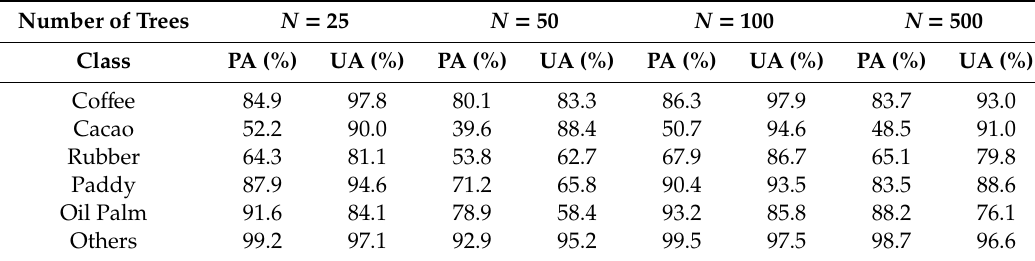
Table 3. Producer’s (%) and User’s (%) accuracy of classified maps for commodity cover using di ff erent Number of Trees. PA refers to Producer’s accuracy and UA refers to User’s accuracy. Number of